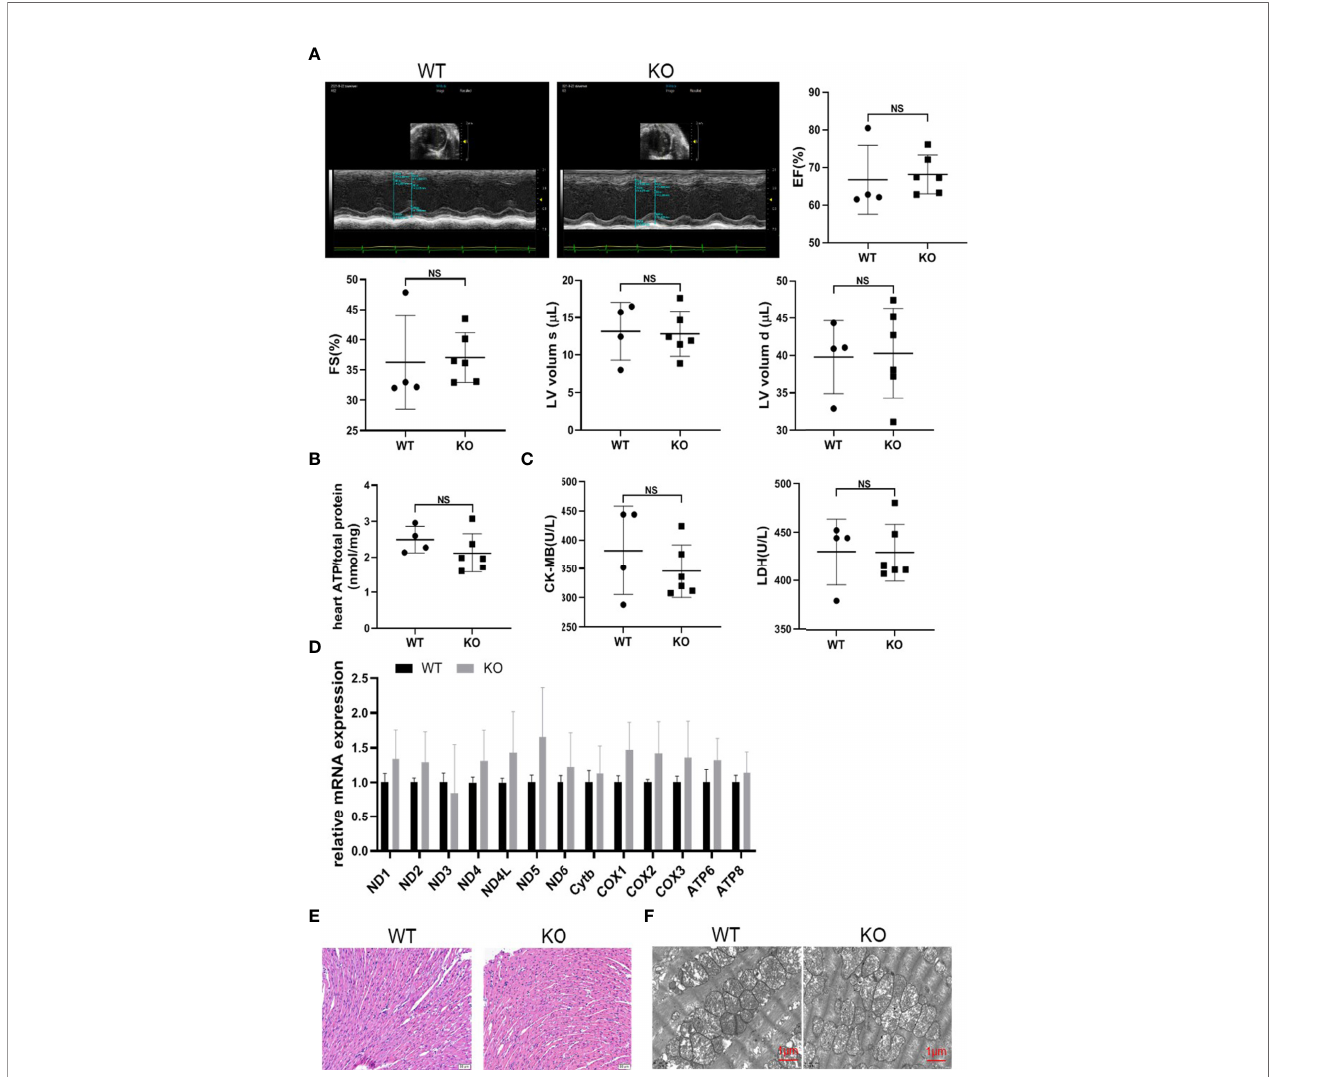
FIGURE 7 | MAVS de fi ciency did not affect cardiac development. (A) . Representative short-axis M-mode echocardiographic images of WT and MAVS -/- mice at the age of 2-3 weeks. EF, FS, and LVVs/d did not differ between WT and MAVS -/- mice. (B) . The ATP content in the hearts of mice did not differ between WT and MAVS -/- mice (n: WT=4, KO=6). (C) . Serum CK-MB and LDH levels in mice (n: WT=4, KO=6). (D) , RT-qPCR analysis of mitochondrial genes in the hearts of WT and MAVS -/- mice (n: WT=4, KO=6). (E) . Representative HE staining images of hearts from WT and MAVS -/- mice revealed no morphologic changes of cardiomyocytes (scale bar: 20 µm). (F) . Representative TEM images of hearts showed no intergroup difference in mitochondrial morphology (scale bar: 500 nm). The quantitative results are shown as the means ± SEM. (NS not signi fi